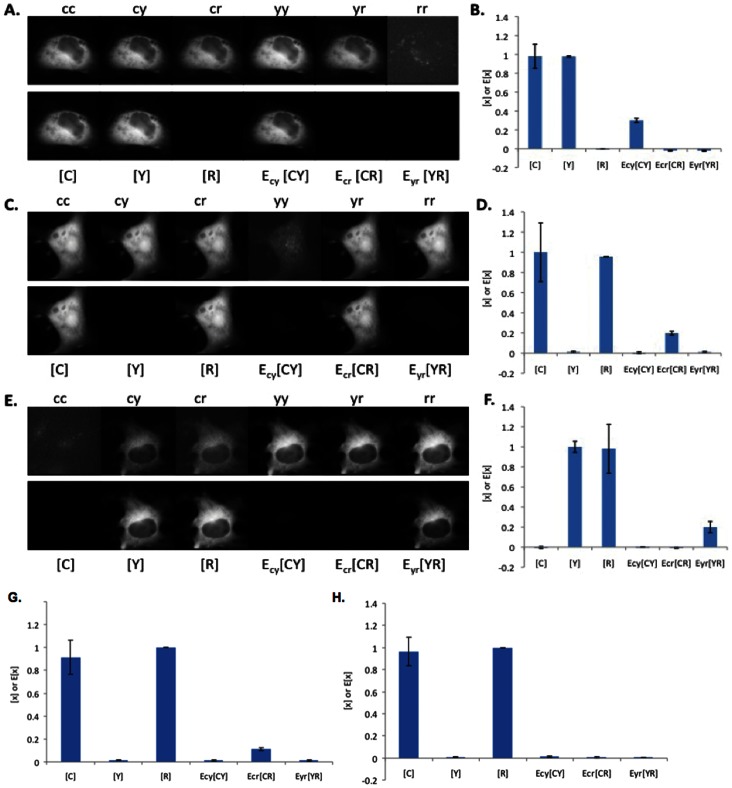
N-Way FRET recovers concentrations and apparent FRET efficiencies from cells expressing FP-FP fusions.Cells were transfected with CFP-YFP (A and B), RFP-CFP (C and D), RFP-YFP (E and F), RFP-darkFP-CFP (G) and RFP-kinesin-CFP (H). The raw images (top rows, independently scaled) were analyzed by N-Way FRET, using B−1, to produce the concentration estimates (bottom rows) ([FP], display scale, 0–1,400 intensity units) and the apparent FRET efficiencies (EFP-FP[FP-FP], display scale 0–500 intensity units). Images are representative of 20 cells per condition. Plots of concentration estimates (C, D, F, G and H) indicated that N-Way FRET accurately recovered the correct one-to-one stoichiometry of each FP in the sample as well as their apparent efficiencies (n = 20 for each). Note the decreasing FRET efficiency observed for increasing size of inserted peptide or proteins: high FRET (RFP-CFP, D), low FRET (darkFP, G) or no FRET (kinesin, H) seen in ECR[CR]. Data from Scope 1.